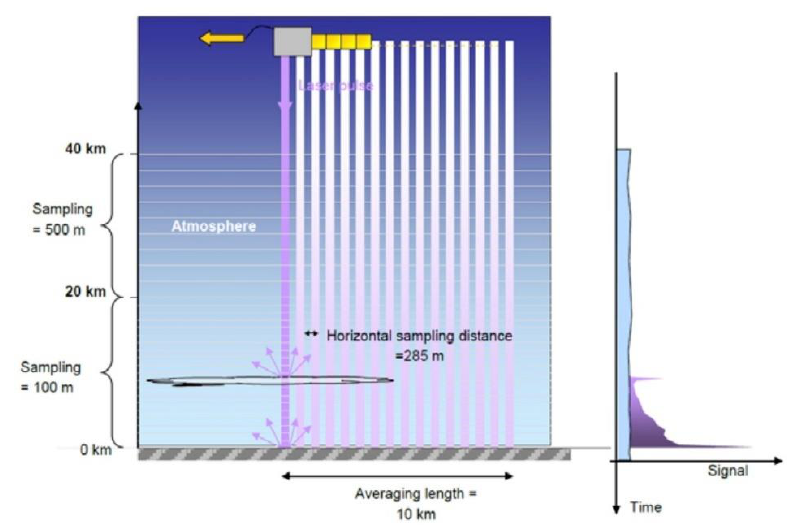
Figure 3. ATLID atmospheric measurement principle.